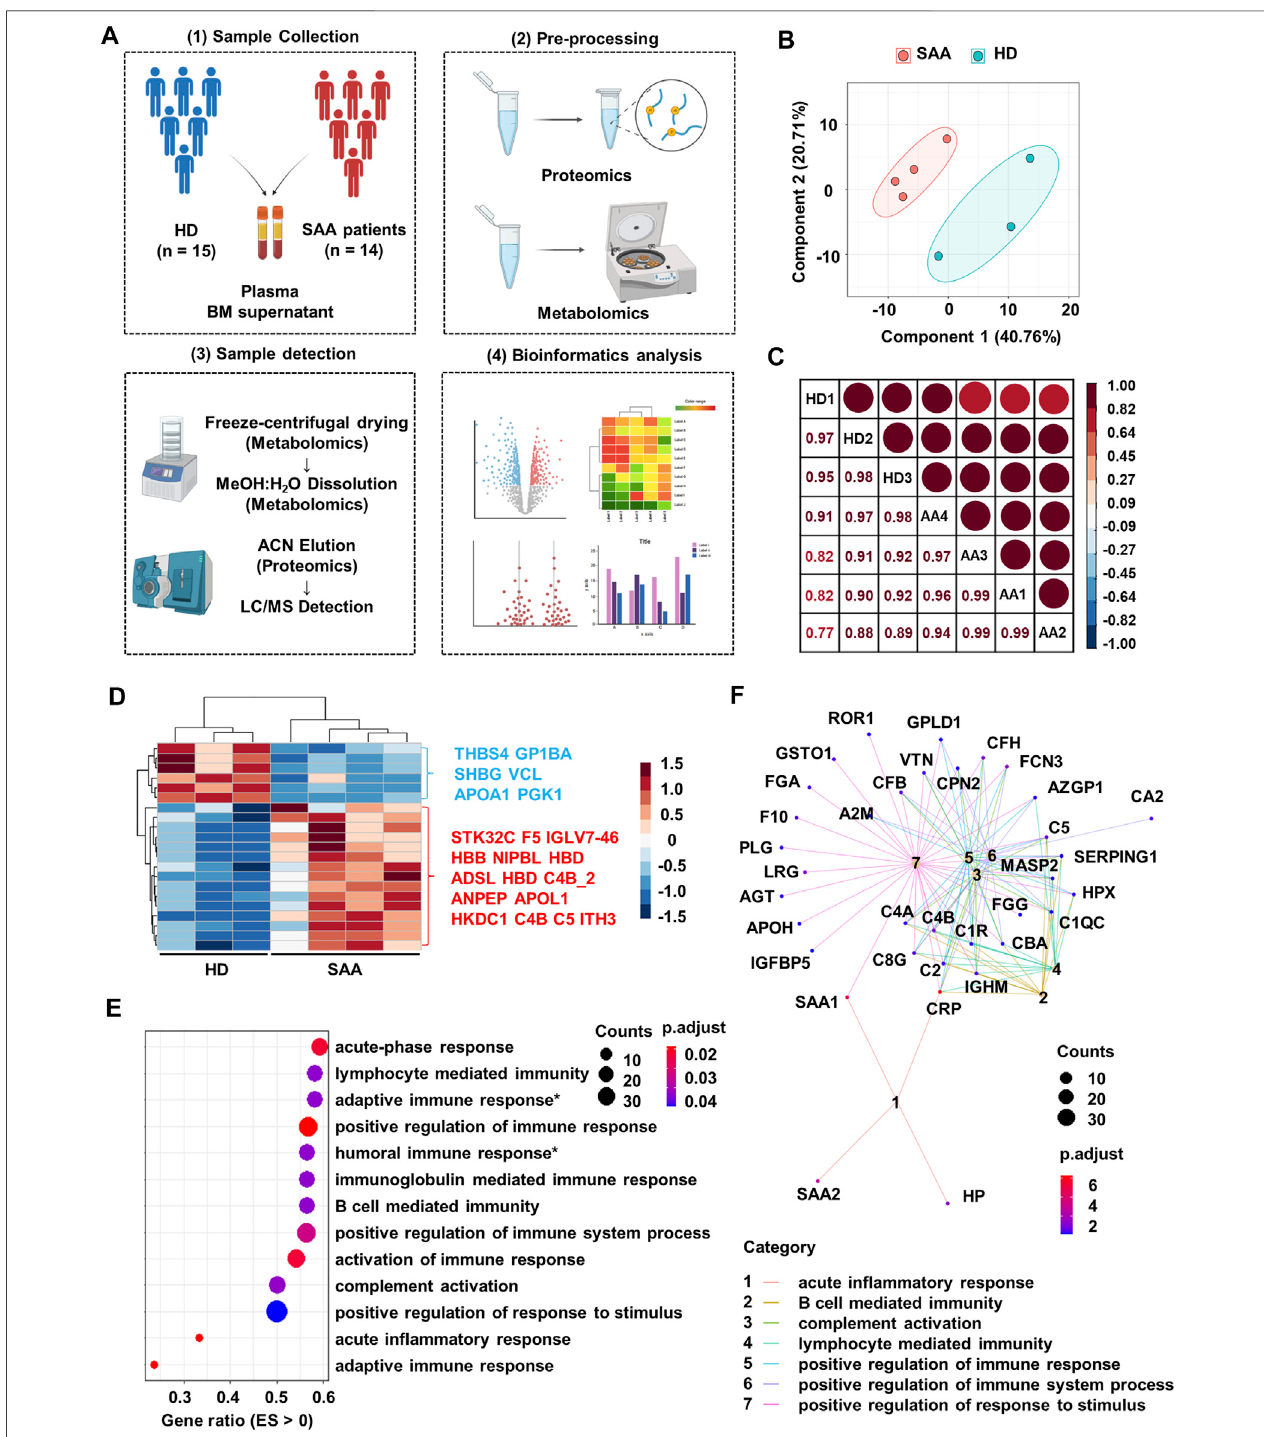
FIGURE 1 | Proteomics pro fi ling of plasma from SAA patients and healthy donors. (A) Schematic diagram of processes to obtain proteomics and metabolomics LC-MSofplasmaandbonemarrowsupernatant fromhealthydonors(HD; n (cid:1) 15)andSAApatients(SAA; n (cid:1) 14). (B) PCAplotoftheplasmaproteinsamplesfromSAA (pink dots) patients and HD (green dots). (C) Pearson ’ s correlation analysis showing the coef fi cient of association of protein composition between each mixed sample fromHD( n (cid:1) 3)andSAA( n (cid:1) 4). (D) Heatmapshowingdifferentiallyexpressedproteins(rows)inplasmafromSAAgroupcomparedwithHDgroup(Student ’ s t -test; fold change > 2, Bonferroni adjusted p -value ≤ 0.05). (E) Dotplot showing enrichment pathways (ES > 0) of upregulated proteins in SAA patients compared with HD by gseGo analysis. ES, enrichment score; Humoral immune response*, humoral immune response mediated by circulating immunoglobulin; Adaptive immune